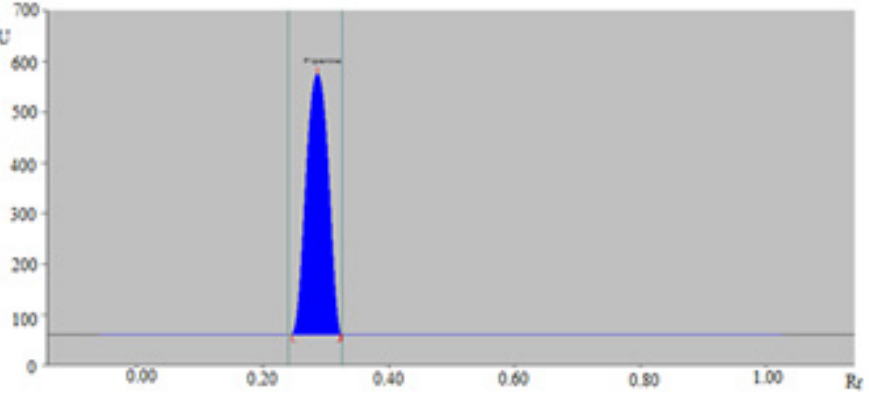
Figure 5. Densitometry chromatograms of PPN in methanolic extract of black pepper (BPPA) recorded using normal-phase HPTLC technique. Table 5. Application of sustainable normal-phase HPTLC technique in determination of PPN in commercial food products in which PPN was extracted by traditional and ultrasound procedures (mean ± SD; n =